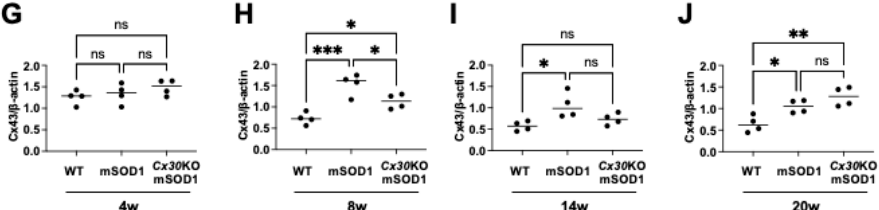
Figure 4. Immunohistochemical and Western blot analysis of connexin dysregulation in the lumbar spinal cord. ( A ) Representative image of immunostaining for Cx30 and GFAP in the lumbar spinal cord of WT, mSOD1, and Cx30 KO-mSOD1 mice at 4, 8, and 20 weeks. ( B ) Representative Western blot images of Cx30 and β -actin in WT, mSOD1, and Cx30 KO-mSOD1 mice at 4, 8, and 20 weeks. ( C , D ) Western blot analysis of Cx30 protein levels normalized to β -actin levels. n = 6. ( E ) Representative image of immunostaining for Cx43 and GFAP in the lumbar spinal cords of mSOD1 and Cx30 KO-mSOD1 mice at 4, 8, 14, and 20 weeks. ( F ) Representative Western blot images of Cx43 and β -actin in WT, mSOD1, and Cx30 KO-mSOD1 mice at 4, 8, 14, and 20 weeks. ( G – J ) Quantification of Western blot data of Cx43 protein levels normalized to β -actin in each group. n = 4. Scale bars: 100 µm. Statistical differences were determined using one-way ANOVA plus Tukey’s multiple comparison test. ns = not significant. * p < 0.05, ** p < 0.01, *** p < 0.001, and **** p < 0.0001.